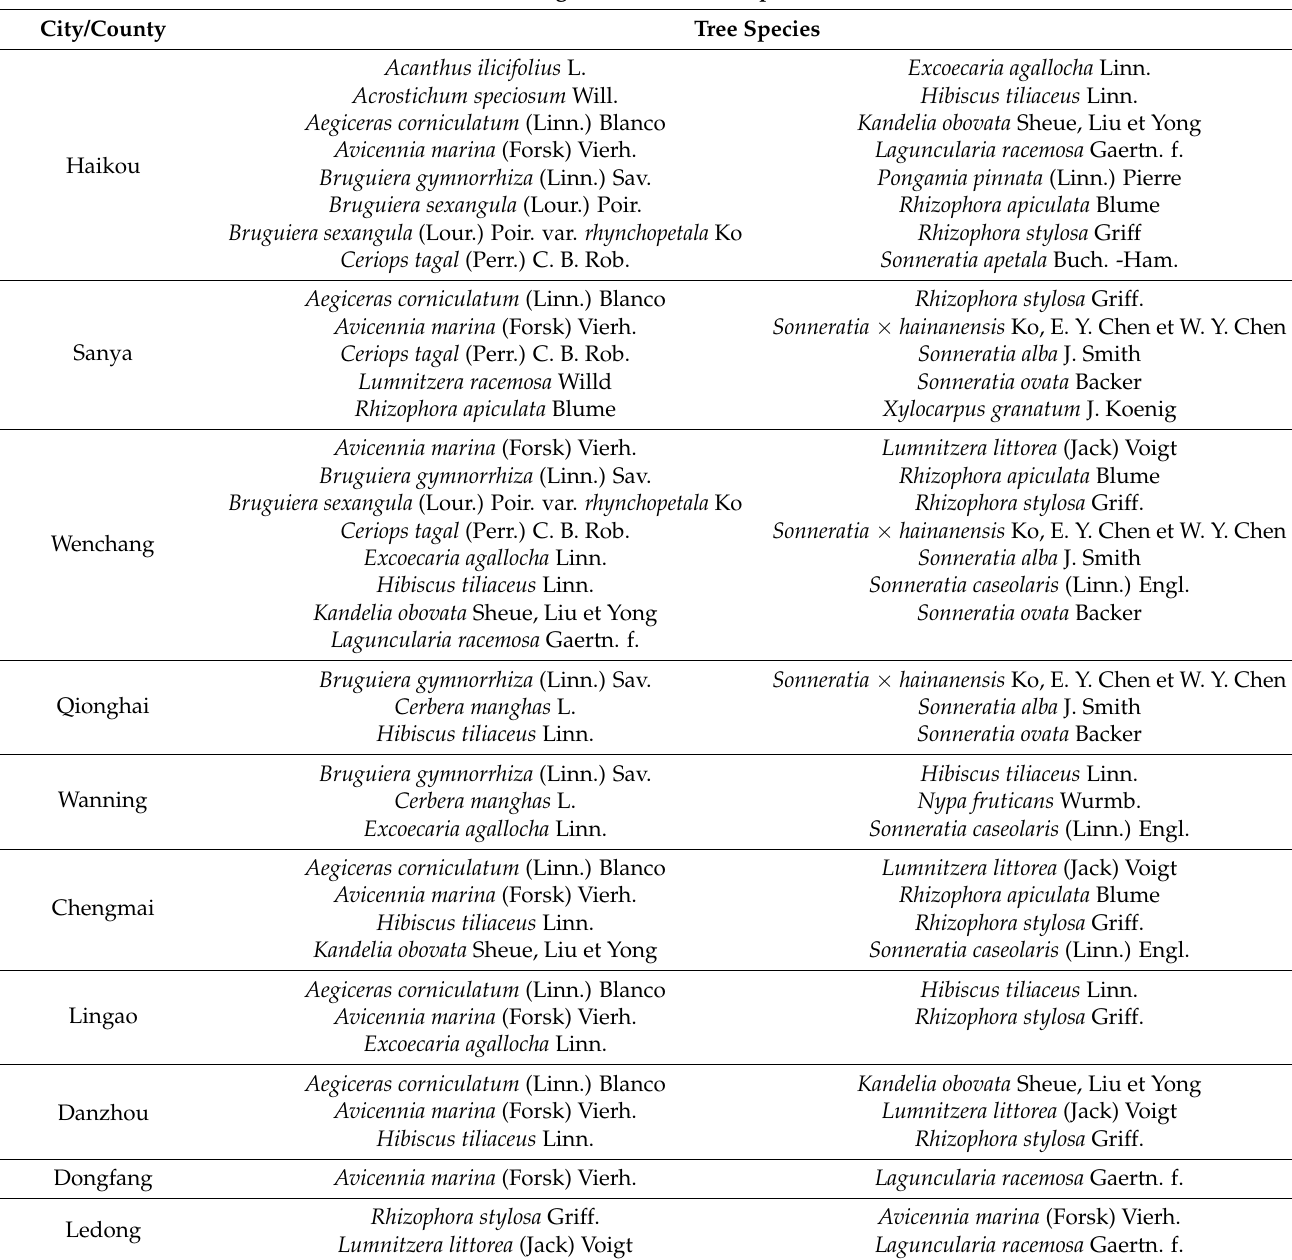
Table A1. Information on dominant tree species of mangrove forests in the Hainan Island obtained from a ground